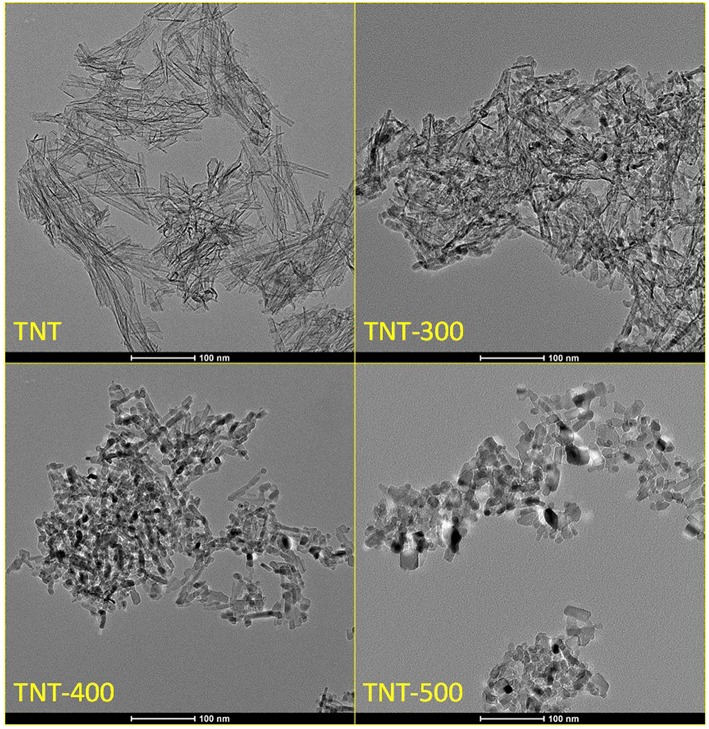
TEM images of TNT and TNT calcined at different temperature. Scale bar: 100 nm.